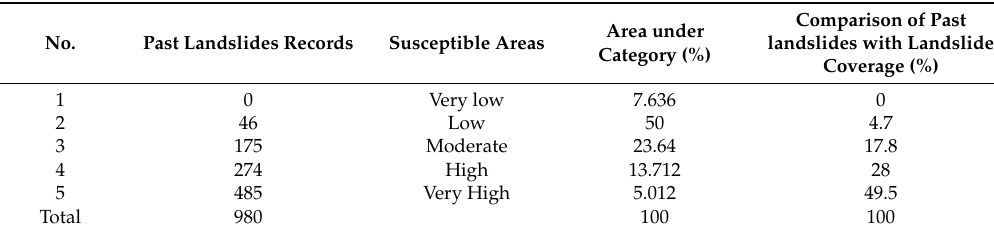
Table 6. Past landslides records compared with produced